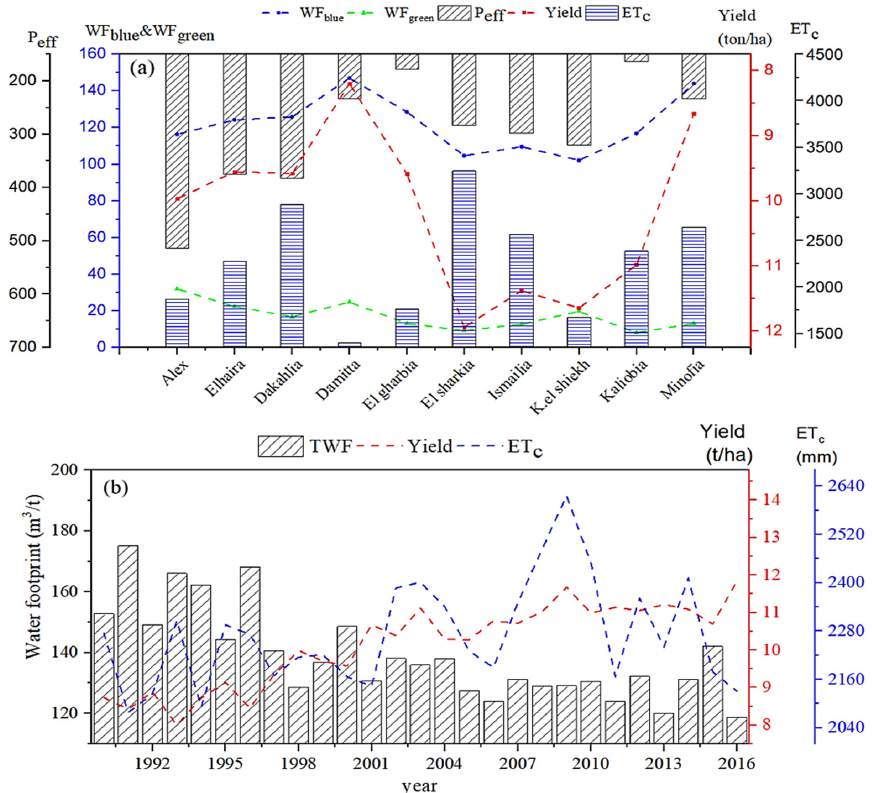
Figure 9. For 1990 to 2016: “( a )” averages of WF blue , WF green , yield, ET c and P eff for each governorate, and “( b )” the time series of total water footprint, yield and ET c .